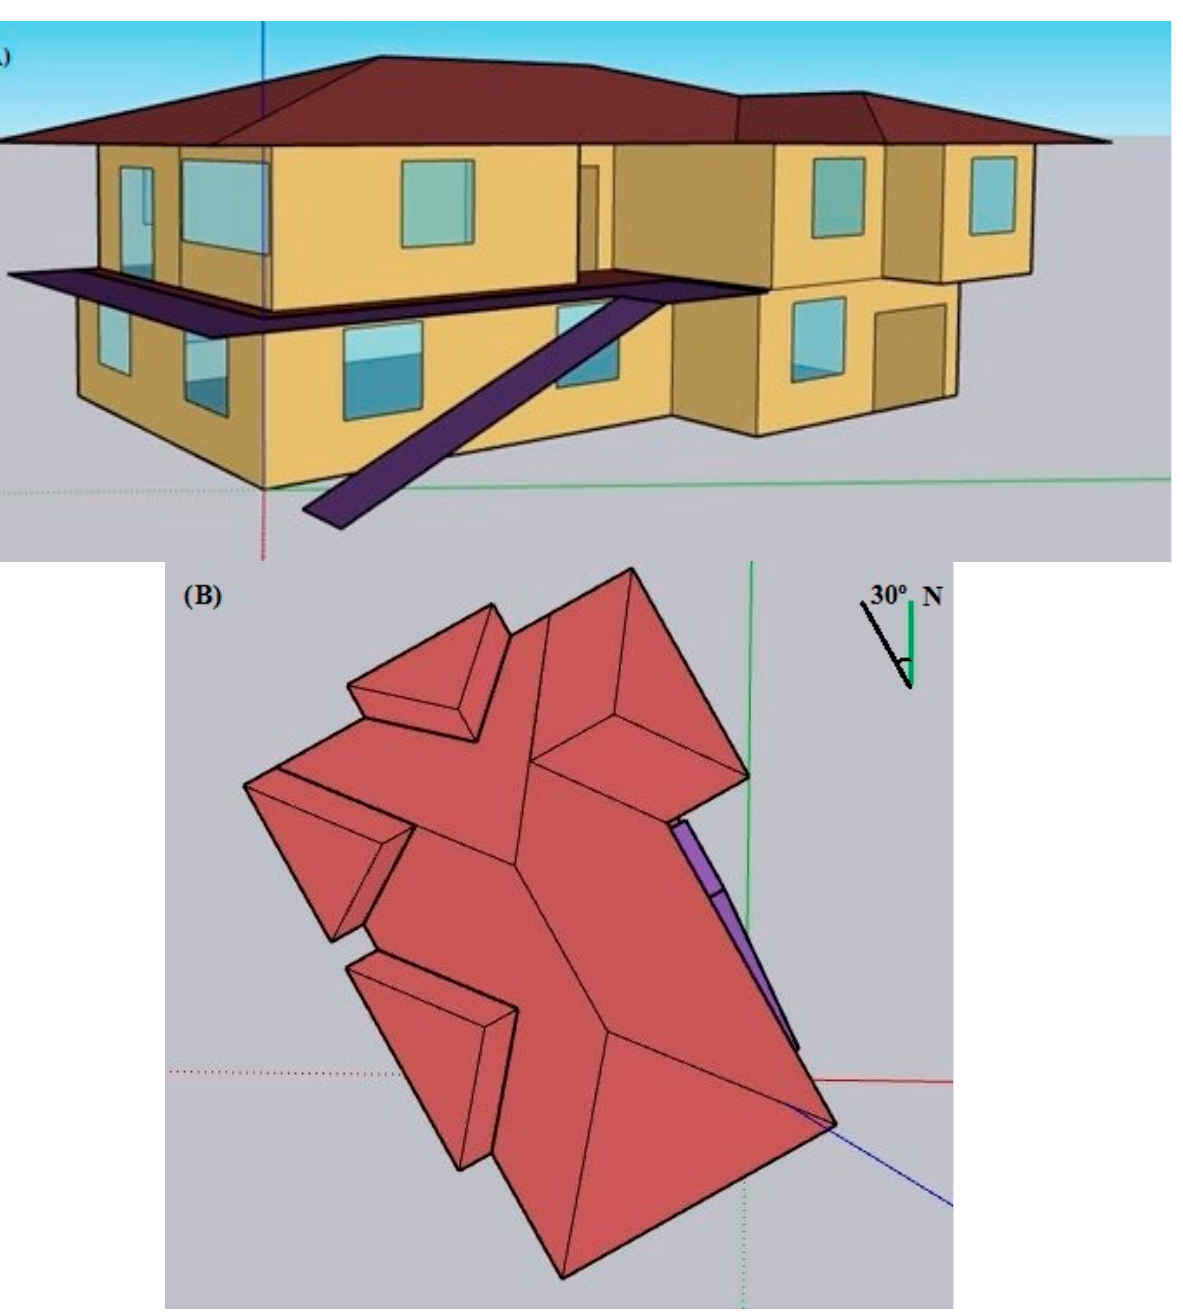
Figure 2. ( A ) House 3D rendering. ( B ) Zenithal view of the building. Table 3. Main thermal properties of the